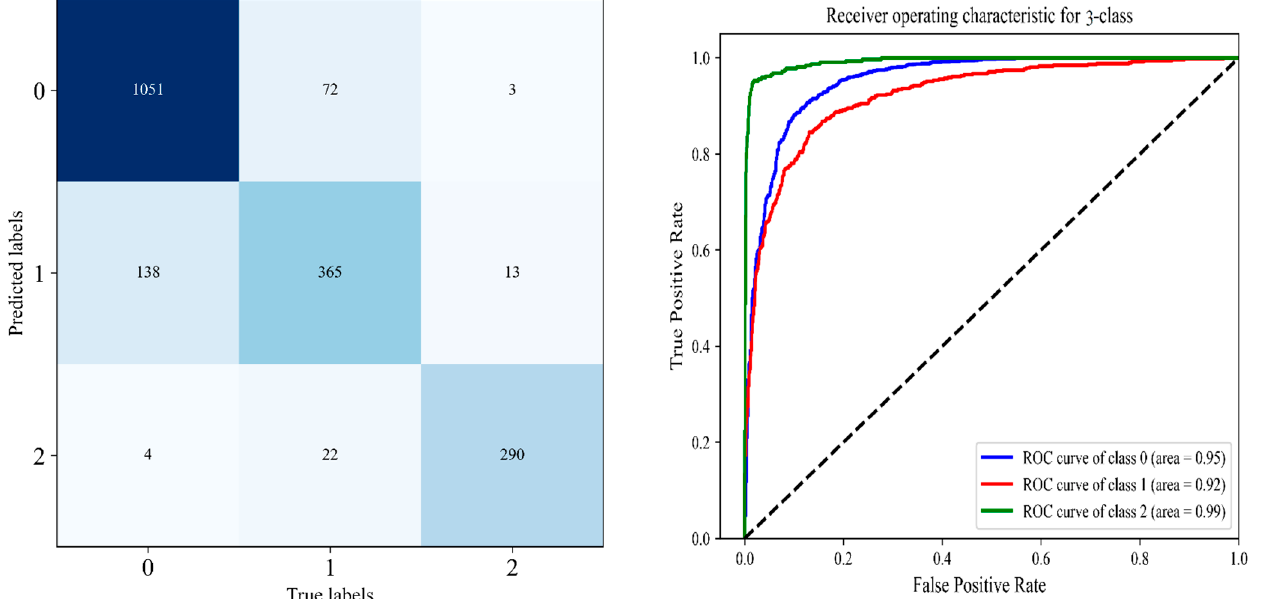
Figure 15. Left is the confusion matrix, and right shows the ROC curve obtained from DHL-II for classifying knee OA using three classes.